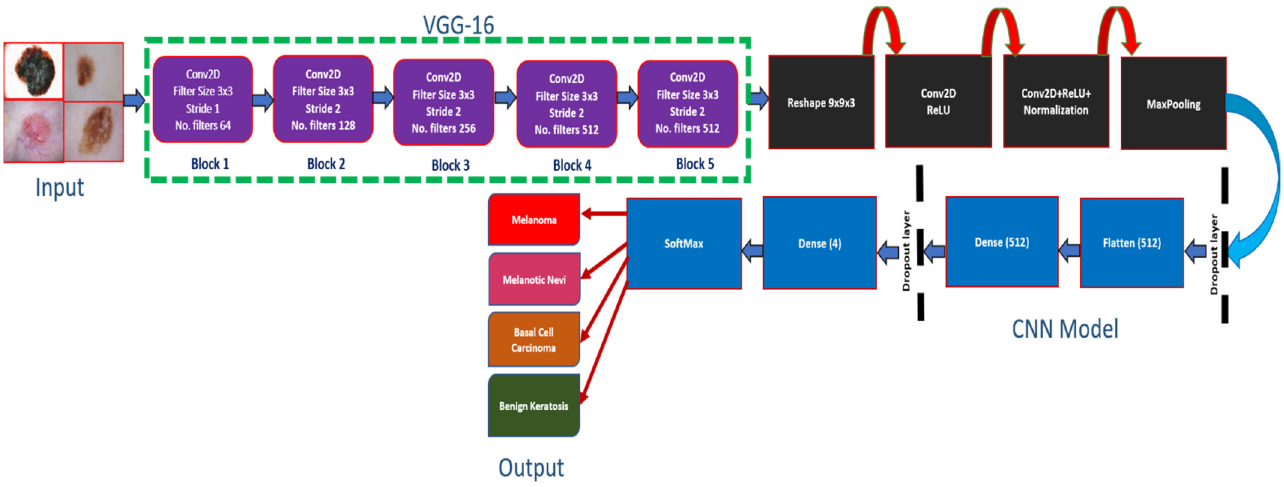
Figure 1. The architecture of Proposed